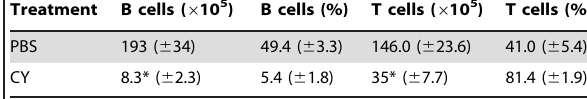
Table 1. Absolute number and percentages of splenic B cells and T cells on day 3.